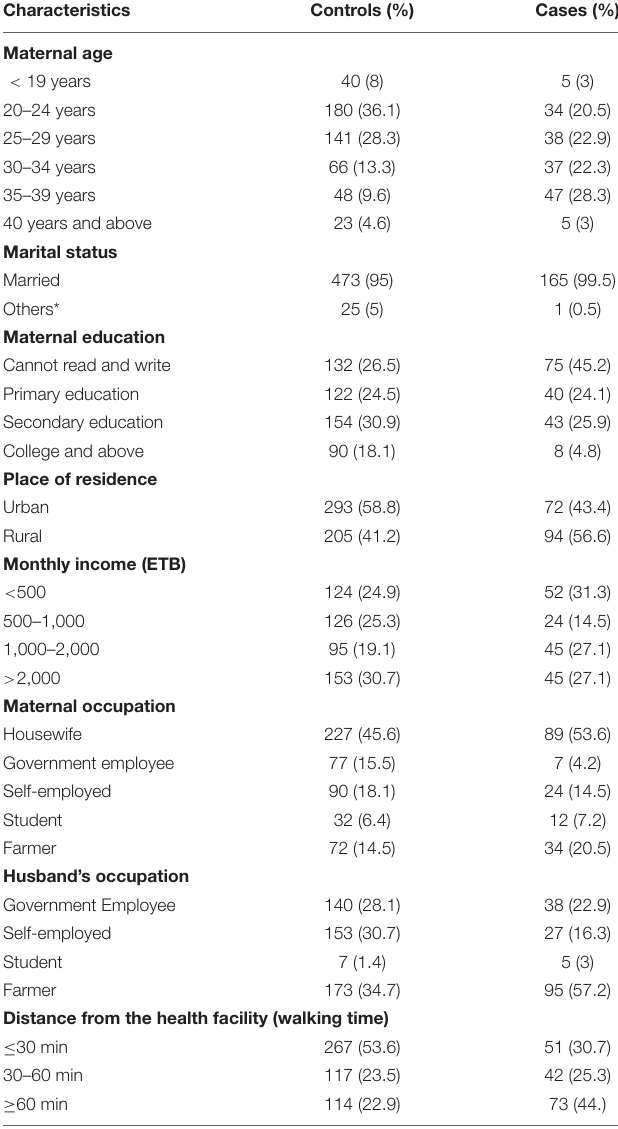
TABLE 2 | Distribution of socio-demographic characteristics over maternal near-miss in West Shoa Zone public hospitals, Central Ethiopia, 2020.